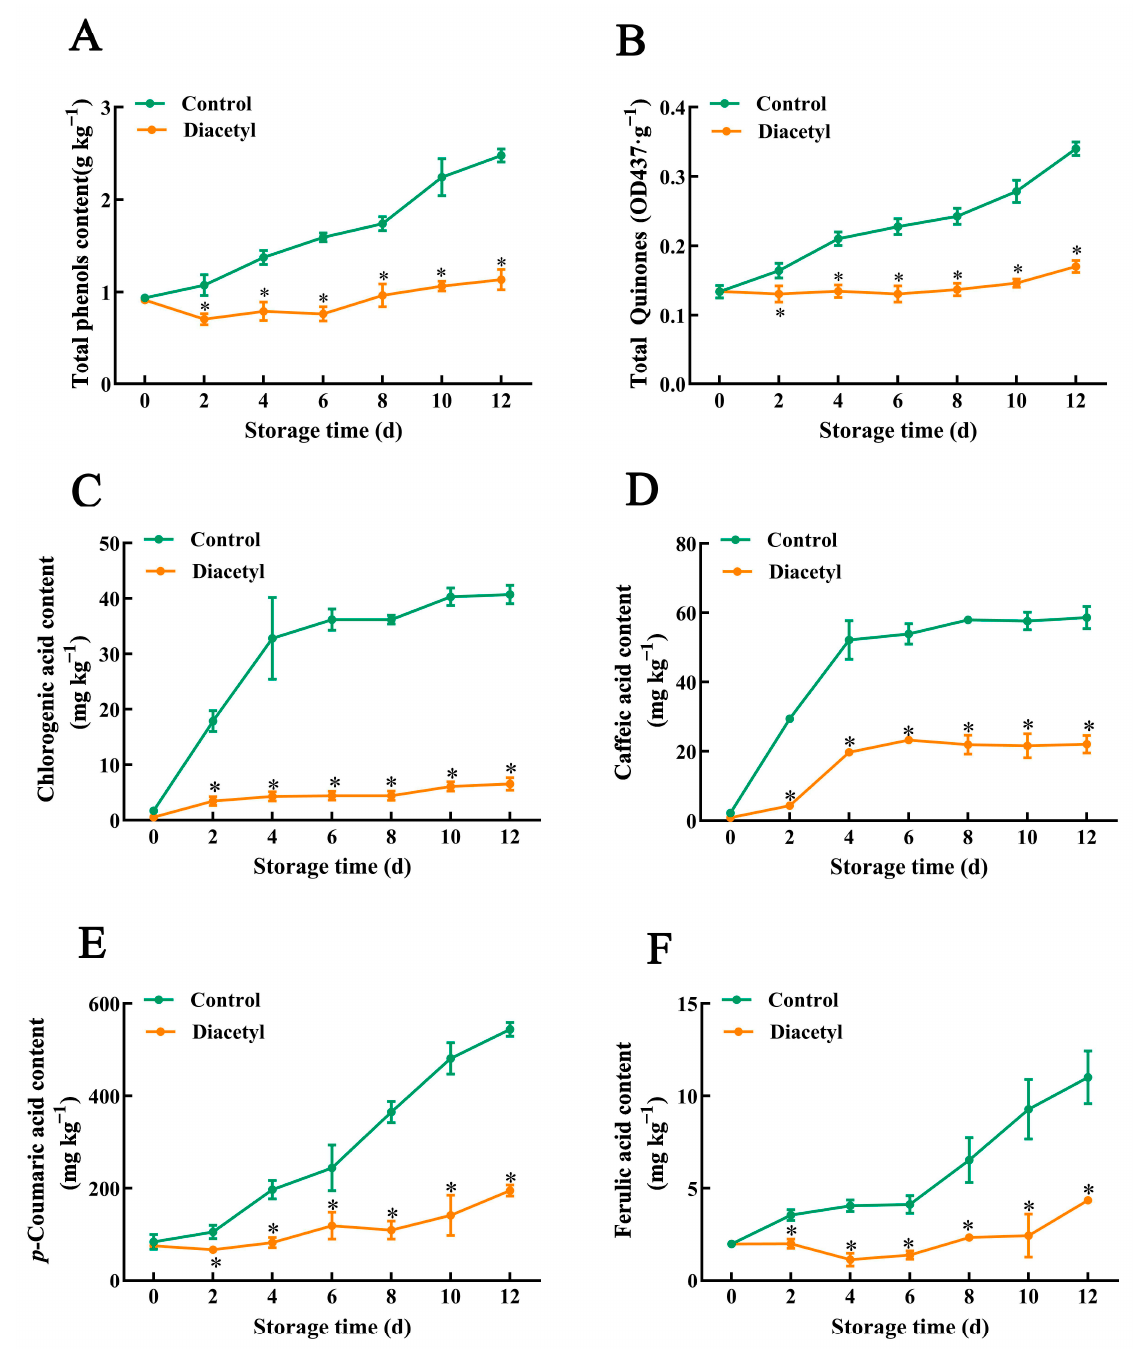
Figure 2. Changes of total phenols ( A ), total quinones ( B ) and individual phenols ( C – F ) in fresh-cut stem lettuce slices during storage time at 4 °C after diacetyl treatment. Asterisks * indicate the significant differences ( p < 0.05) between control and treated groups in the figure at the same storage time. Vertical bars represent standard